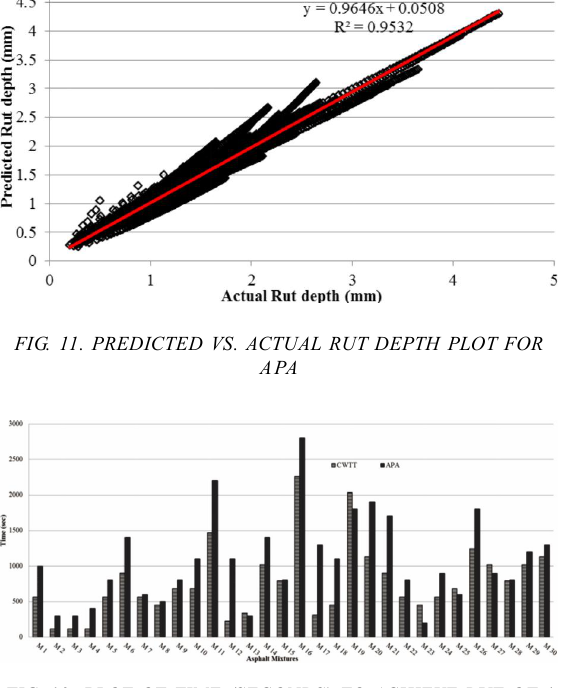
FIG. 12. PLOT OF TIME (SECONDS) TO ACHIEVE RUT OF 1 MM FOR CWTT AND APA AT 50 O C